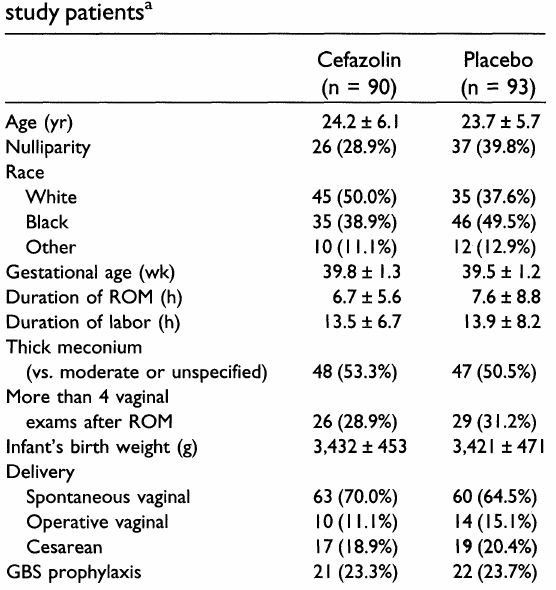
TABLE 2. Outcome variables Cefazolin